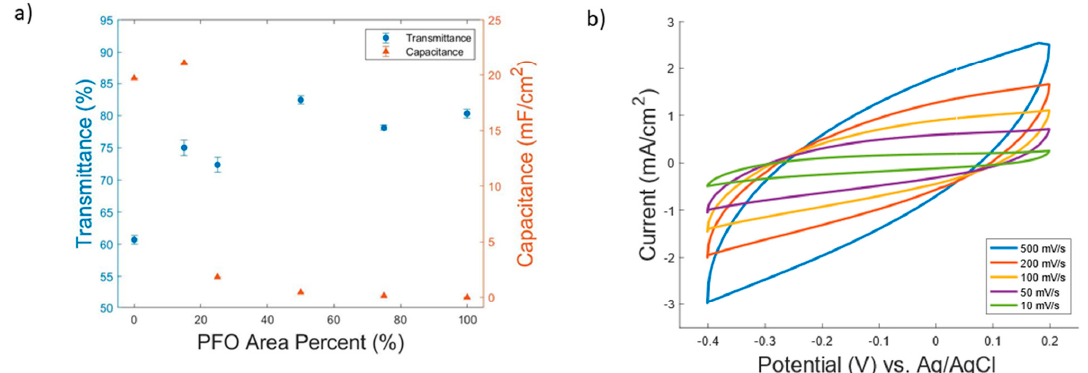
Figure 2. ( a ) Double Y plot comparing film transmittance and capacitance as a function of the composition of the RIR-MAPLE target. Error bars are included for transmittance measurements; however, error for capacitance measurements are too insignificant to include ( < 0.5% of average); ( b ) cyclic voltammogram (CV) curves of P15M85 electrode across multiple sweep rates in 0.5 M Na 2 SO 4 with a Ag / AgCl reference